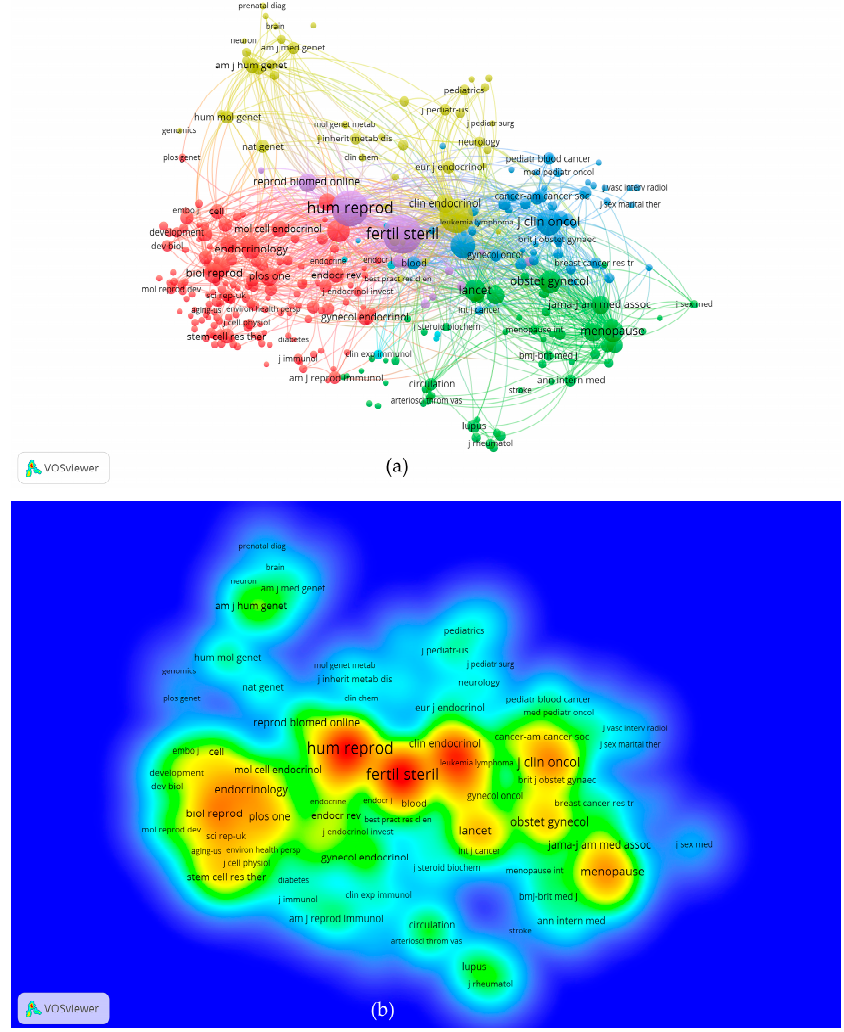
Figure 4. VOSviewer visualization map of most commonly cited journals related to therapy for POI. ( a ) Co-citation network of the most commonly cited journals. Of the 4802 cited journals, 331 met the threshold. ( b ) The density map of the most commonly cited journals. The big nodes represent journals with large numbers of